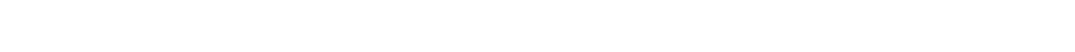
FIGURE 3 |Averaged “target” responses for each orientation in the probe trials as a function of emotion and salience. Error bars represent